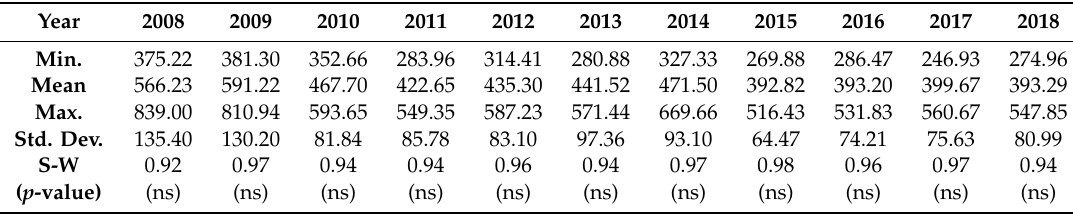
Table 1. Descriptive statistics for age-standardized emergency visit rate by year.